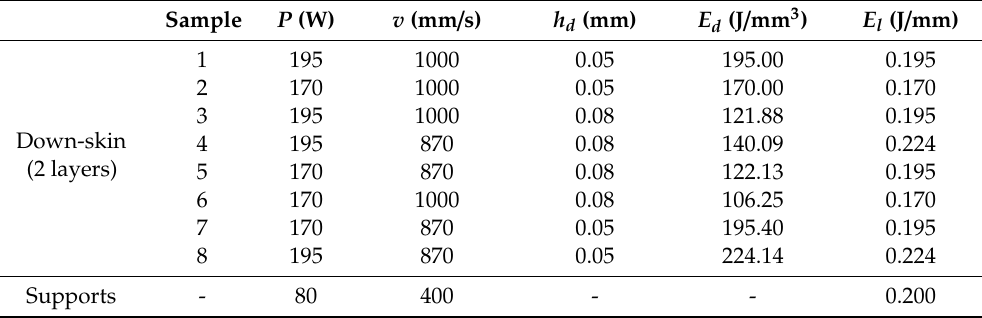
Table 2. Process parameters, energy density and linear for down-skin and support.